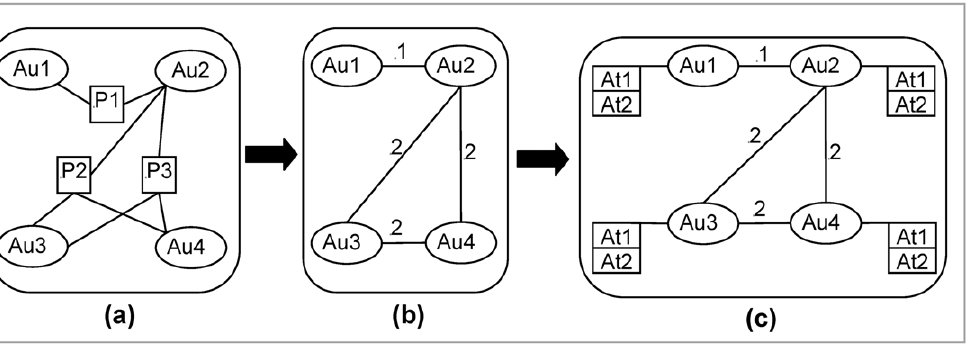
Figure 1. Illustration of a co-authorship network. (a) author-paper network for three papers written by four authors; (b) corresponding co- authorship network; and (c) co-authorship network showing same network attributes for each author. Au stands for Author , P stands for Paper and At stands for network attribute (e.g., degree centrality ) of authors. Although in this figure we consider two attributes (i.e., At1 and At2 ) for illustration, we consider network attributes of degree centrality , closeness centrality and betweenness centrality of all authors for research analysis in this study.